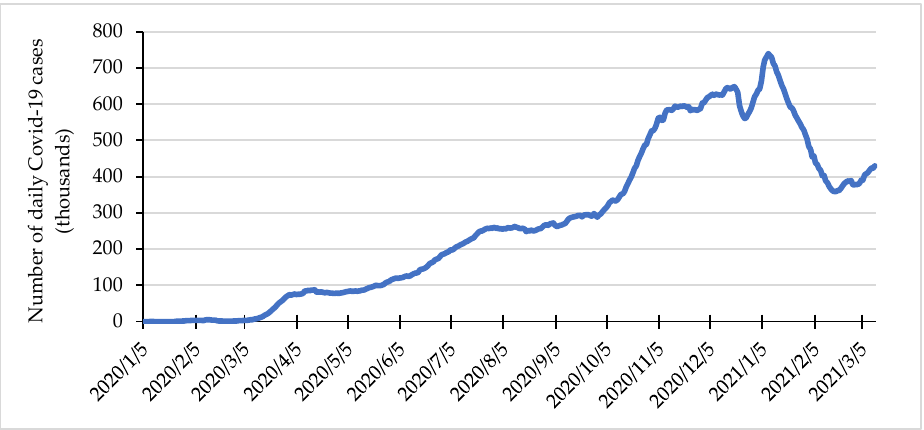
Figure 3. Daily COVID-19 cases. Source: own elaboration on the basis of data from https://ourworldindata.org/covid-cases (accessed on 19 April 2021).